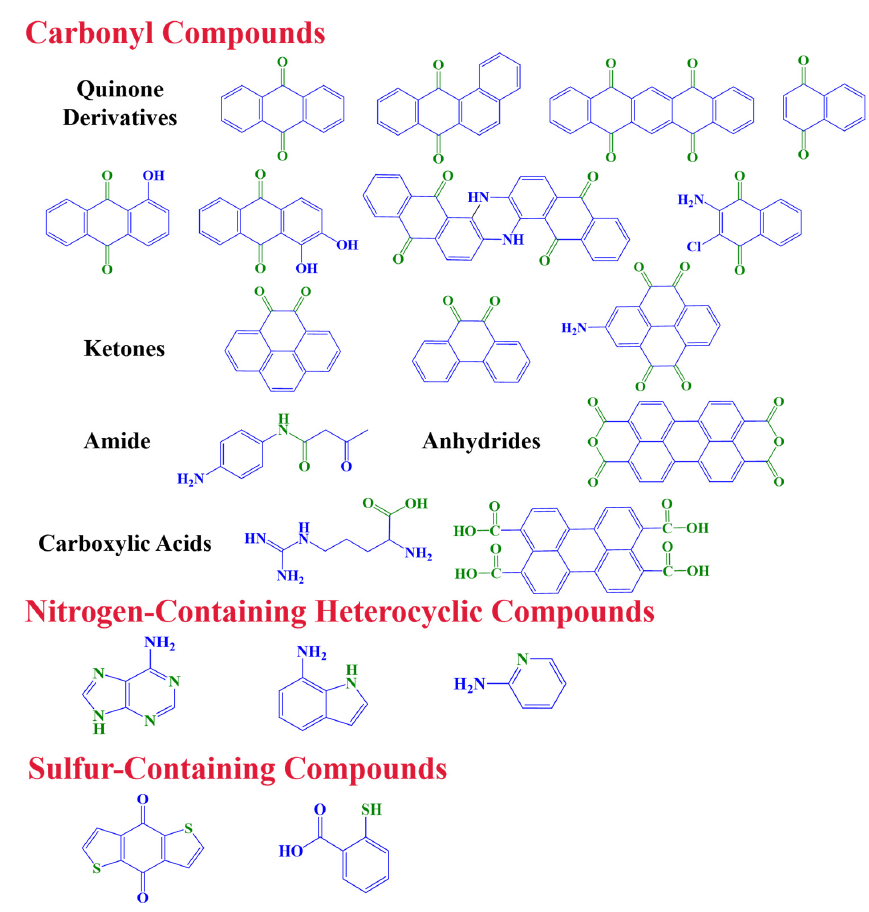
Figure 3. Classification of organic small-molecule electrodes. Table 1. The electrochemical performance of organic small-molecule electrodes in different types.